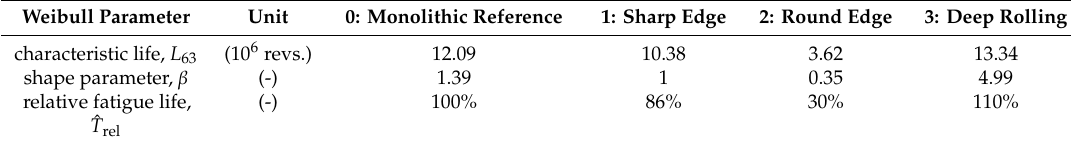
Table 3. Weibull distribution parameters and relative fatigue life to reference